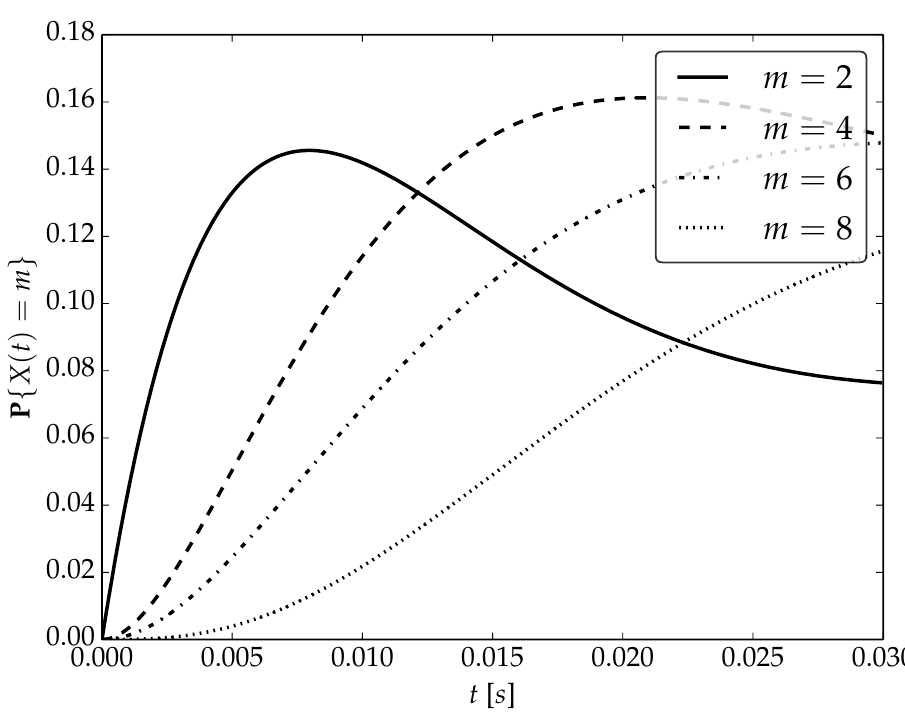
Figure 12. Transient distributions P { X ( t ) = m } for N = 6, batch distribution P 2 and ρ =